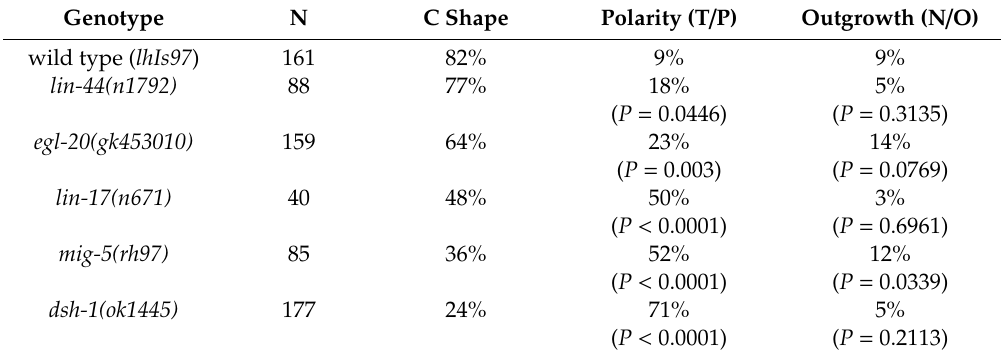
Table 1. VD13 morphology by genotype.